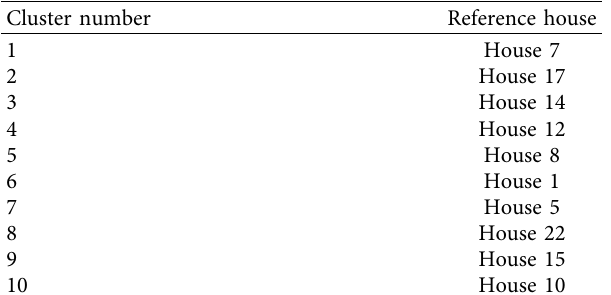
Table 2: Houses for reference in each